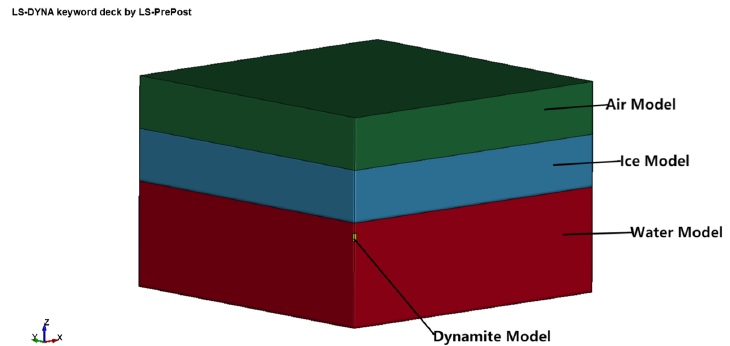
Figure 2. Numerical model of ice blast.